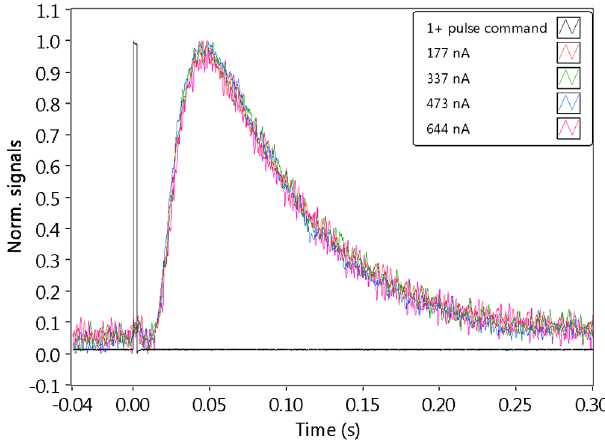
FIG. 7. 1 þ injection pulse and Rb 19 þ normalized signal responses to several 1 þ beam pulse intensities.